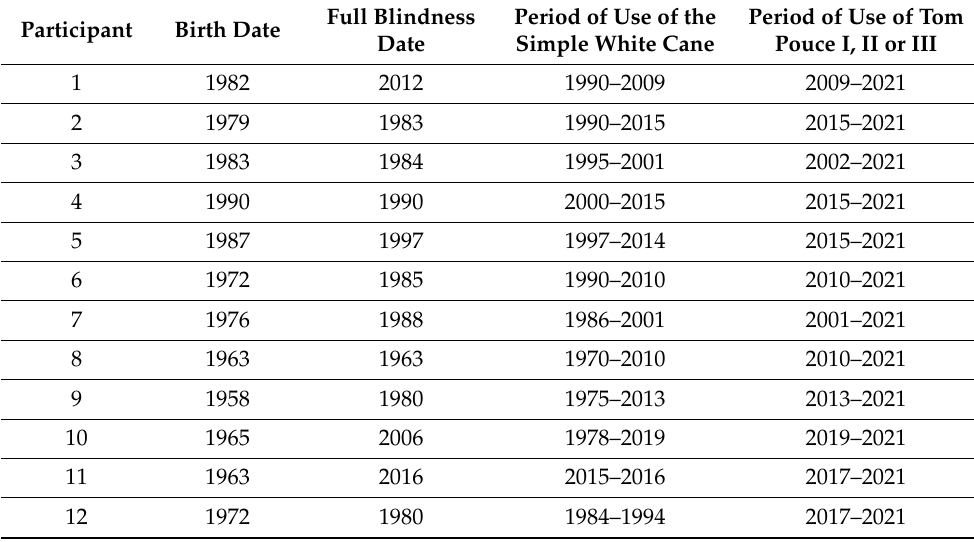
the white cane and the period of use of the Tom Pouce I, II or